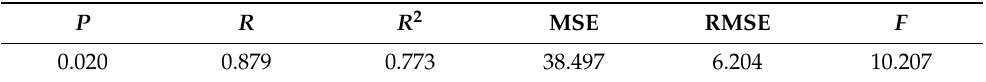
Table 2. The F -test results for the prediction model of damage